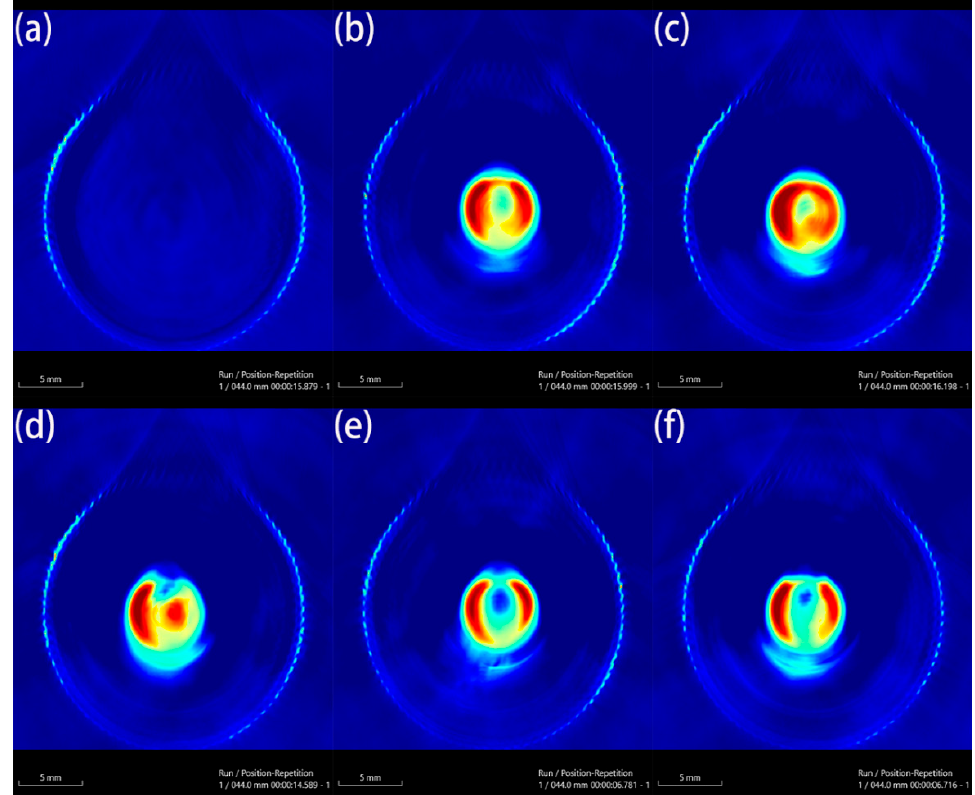
Figure 8. Photoacoustic imaging (PAI) of different concentrations of Au-UCNPs-DSPE-PEG 2K , ( a ): 0